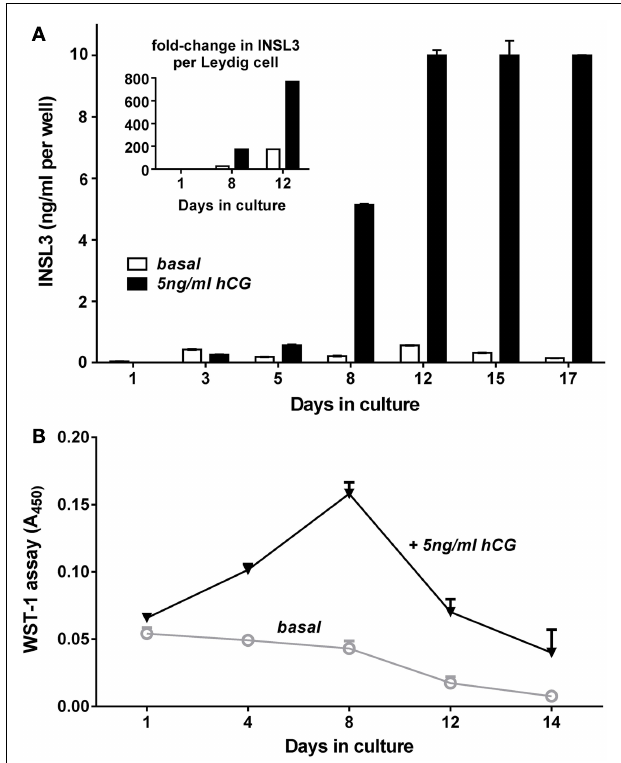
FIGURE 4 | Differentiation in vitro of post-natal day (PND) 10 rat Leydig cells in the absence (open bars) or presence (filled bars) of hCG . (A) Cells were purified from the abdominal testes of PND10 male Sprague Dawley rats by mechanical dispersion followed by unit sedimentation, then cultured in serum-free medium at 400,000 cells per well of 12-well plates at 37°C. Medium was changed every 2–3days, with aliquots collected exactly 48h after the last medium change, for measurement of INSL3 using rat INSL3-specificTRFIA (10). (B) Cells prepared as above were seeded in parallel at 30,000 cells per well into 96-well plates and subjected to the WST-1 (4-[3-(4-Iodophenyl)-2-(4-nitro-phenyl)-2H-5-tetrazolio]-1,3-benzene disulfonate) assay to measure cell numbers, as described by the manufacturers (Roche Applied Science (Castle Hill, NSW, Australia).The inset in the upper panel indicates the fold-increase in INSL3 secretion calculated on a per cell basis for key times relative to basal expression on day 1, thus representing the differentiation of the individual Leydig cells, discrete from any effects on cell proliferation or cell death.This shows that while hCG has a marked effect on Leydig cell proliferation and/or survival, it is not essential for cell differentiation, though it does augment it. Animal experimentation was conducted under the terms of permit S-2010-102 of the Animal Ethics Committee, University of Adelaide.